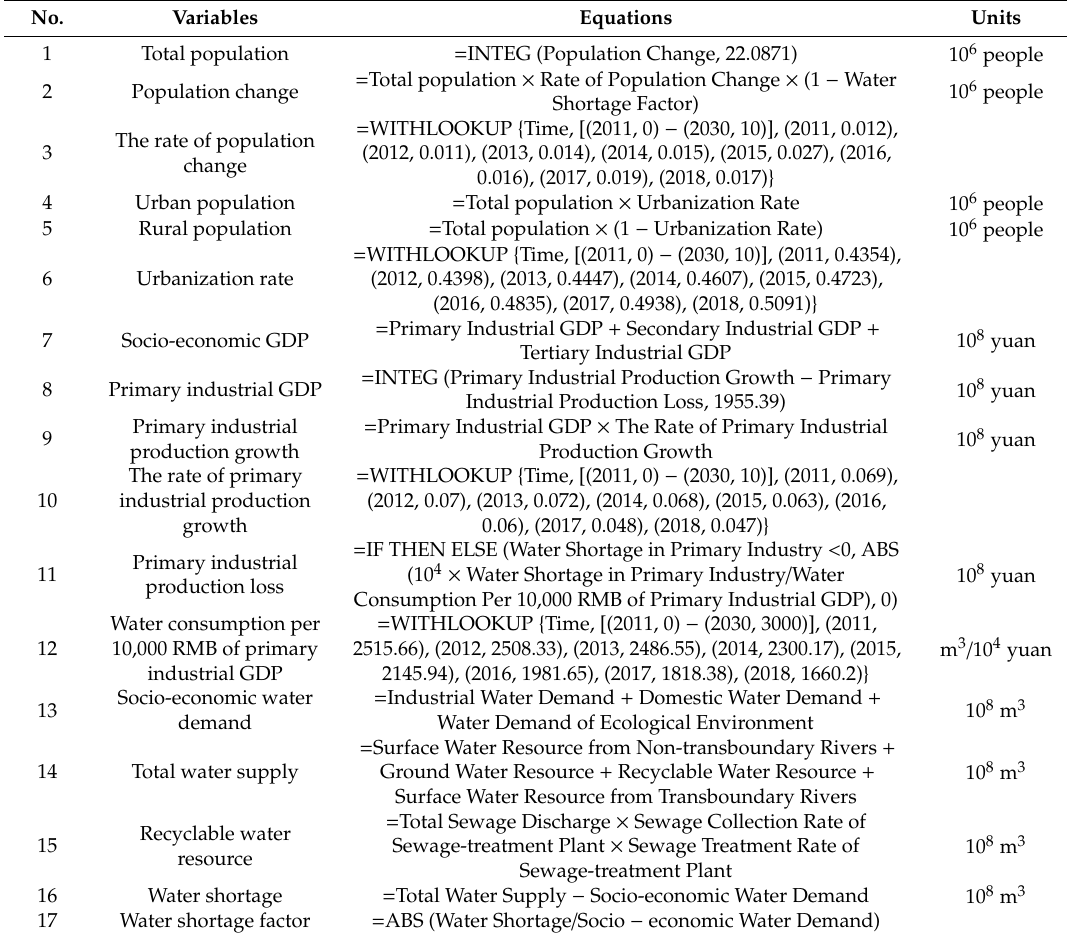
Table 1. The main variables and equations of the